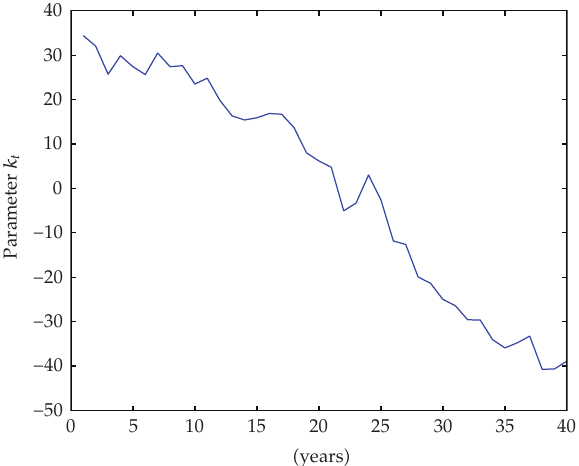
(cid:8) Figure 3: Parameter k t based on the Swedish male 1921–1960 mortality